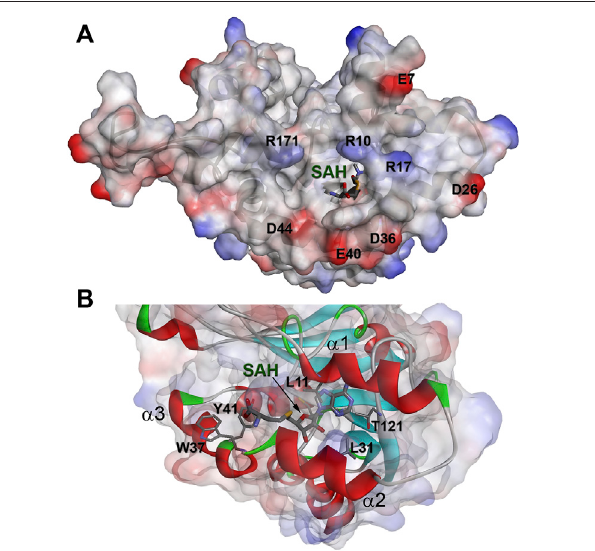
FIGURE 4 | The binding site of SAH in complex with WBSCR27. (A) Electrostatic surface potential of the protein. (B) Amino acids of WBSCR27 participating in the interaction with